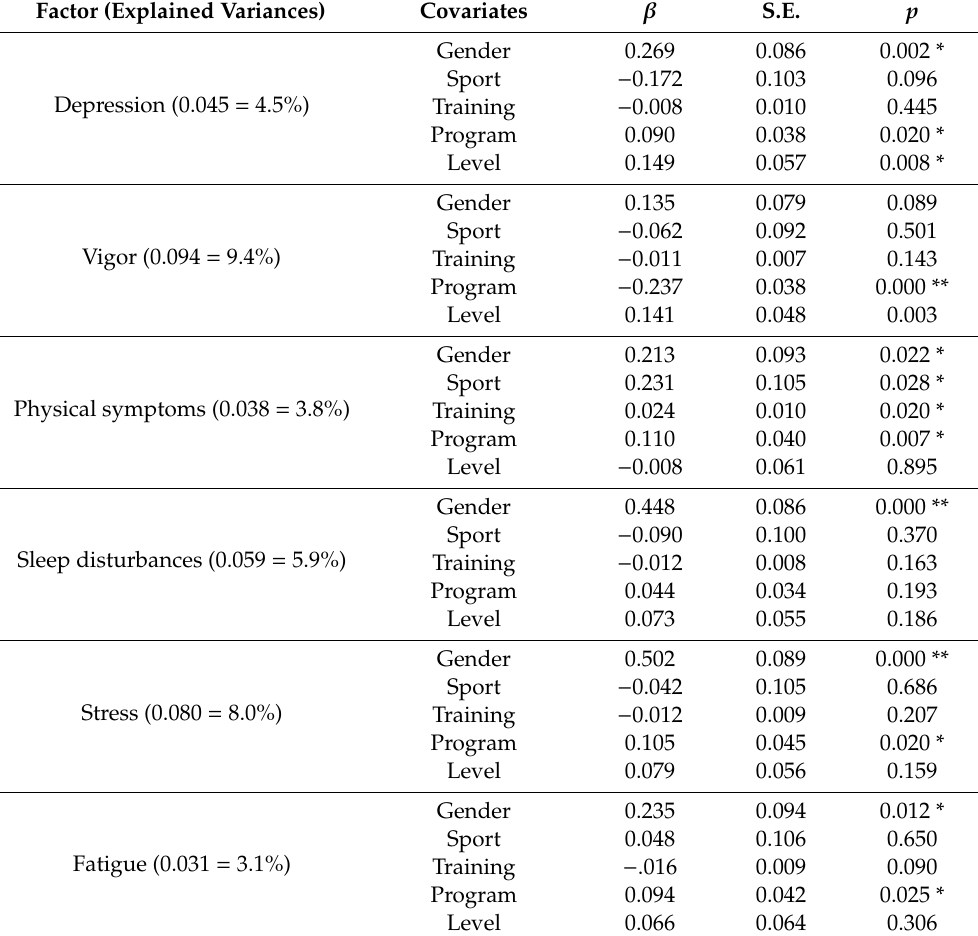
Table 10. MIMIC model results of the covariates gender, age, type of sport, hours of training per week, county, school program, and school level on the factors depression, vigor, physical symptoms, sleep disturbances, stress, and fatigue. Factor (Explained Variances) Covariates β S.E. p